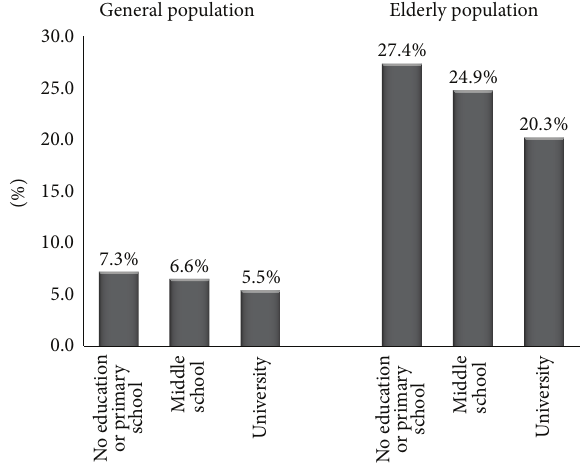
Figure 3: Education difference in the prevalence of constipation. Prevalence rate of constipation increased with less education in general population and elderly